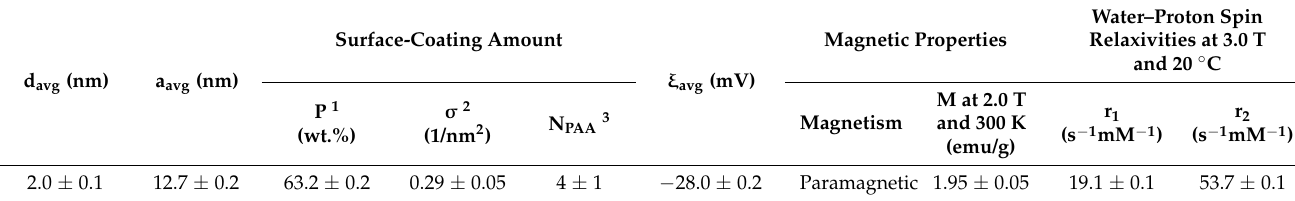
Figure 2. ( a ) HRTEM image (dotted circles indicate PASA-coated Gd 2 O 3 nanoparticles). ( b ) Log-normal function fit to the particle size distribution to obtain d avg . ( c ) Log-normal function fit to a DLS pattern to obtain a avg . Table 1. Average particle diameter (d avg ), average hydrodynamic diameter (a avg ), surface-coating amount (P, σ , N PAA ), magnetic properties, and water-proton spin relaxivities (r 1 , r 2 ) of PASA-coated Gd 2 O 3 nanoparticles. d avg (nm)